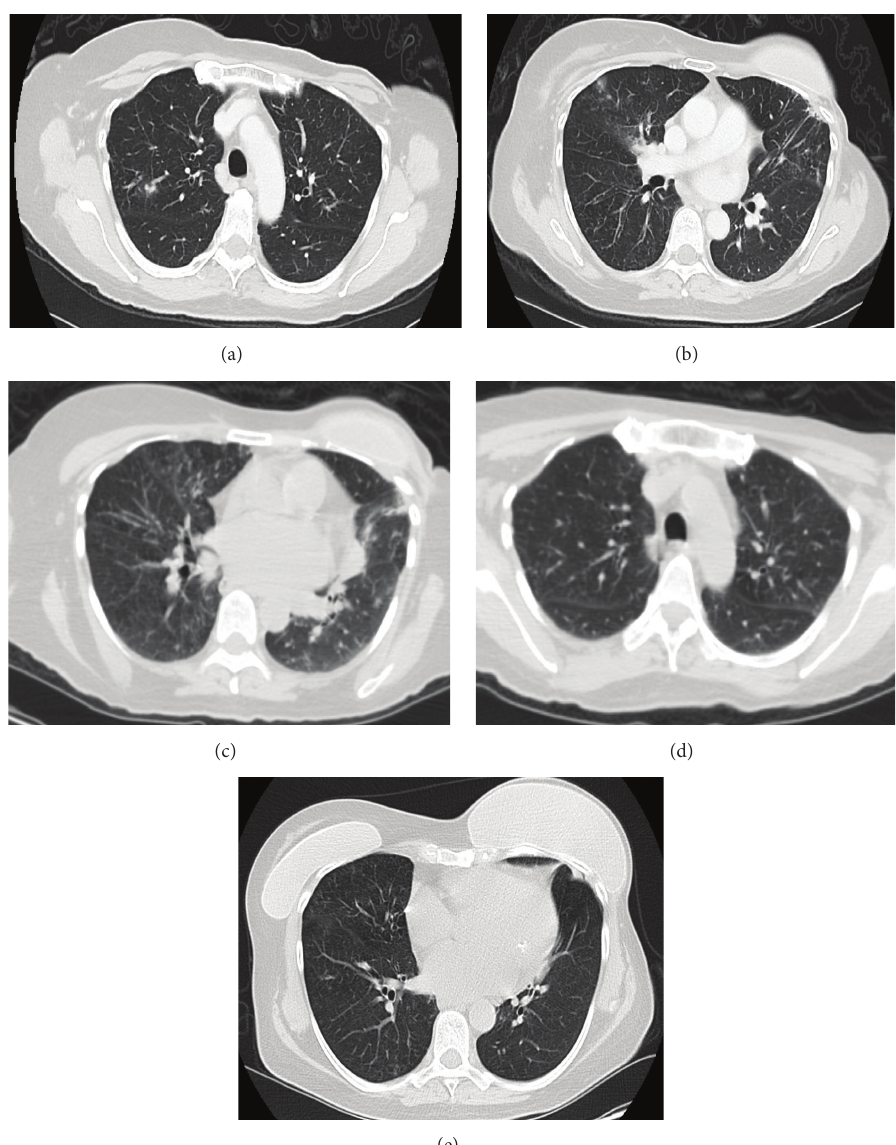
Figure 2: Chest CT findings in Case 2 . Right upper and middle lobes nodular opacities (a) and lingular bronchiectasis (b). Waxing and waning opacities involving the right upper and middle lobes and lingula (c). Interval resolution of right middle lobe (d) and lingular opacities